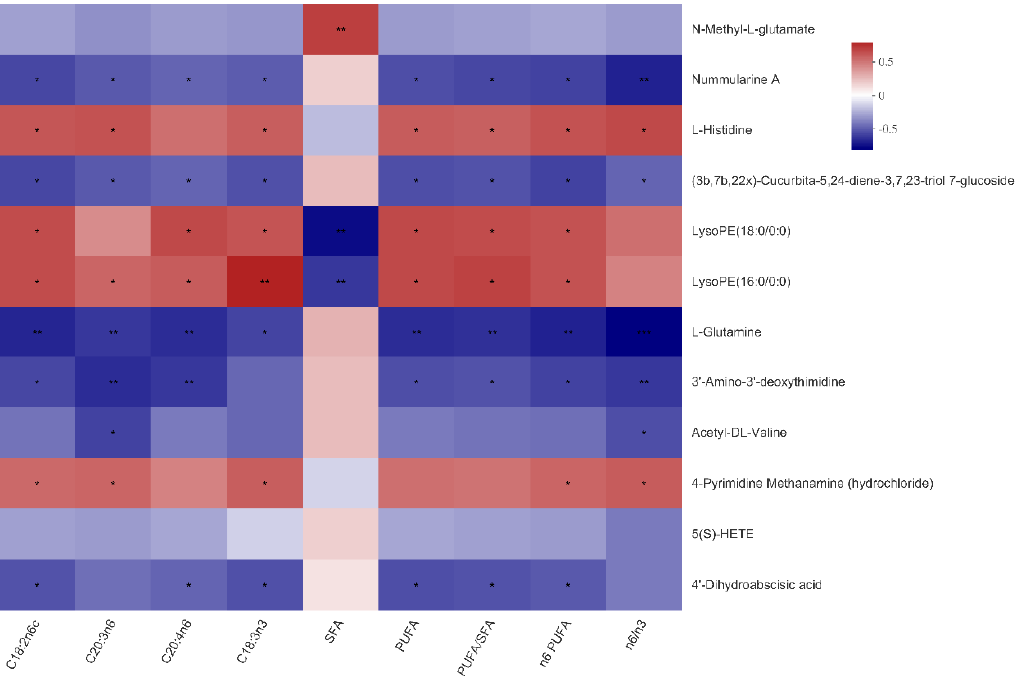
Figure 4. Correlations between serum metabolites and fatty acid composition in the Longissimus thoracis muscle of the Bama Xiang mini-pigs. The top 50 metabolites were selected. Levels of significance are defined as * p < 0.05, ** p < 0.01, and *** p < 0.001.